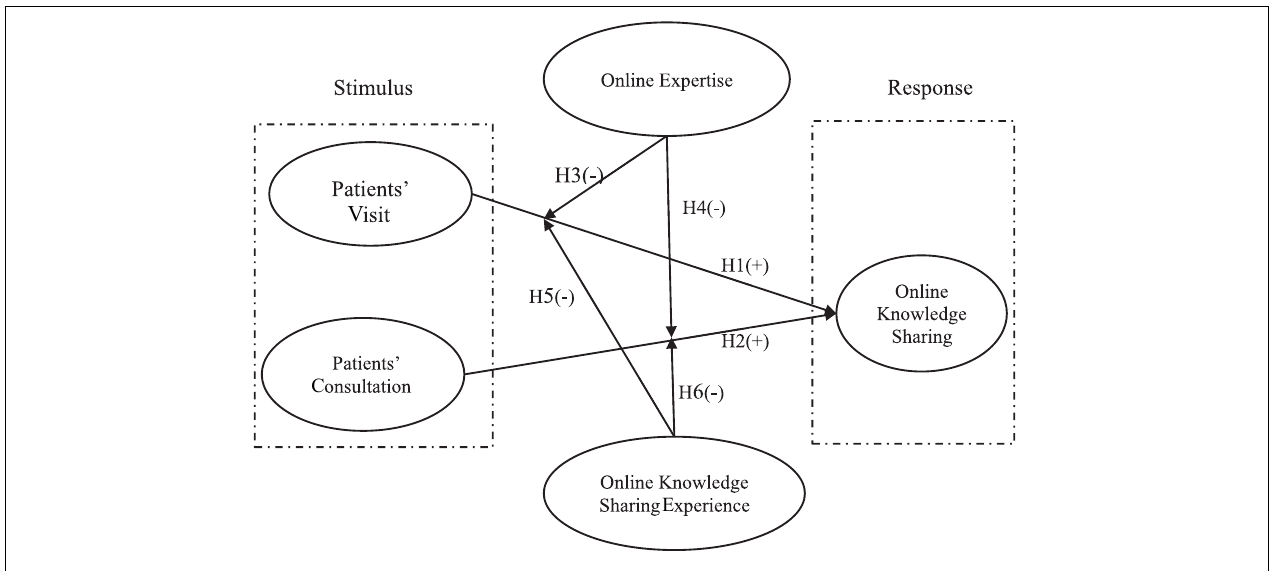
FIGURE 1 | Research